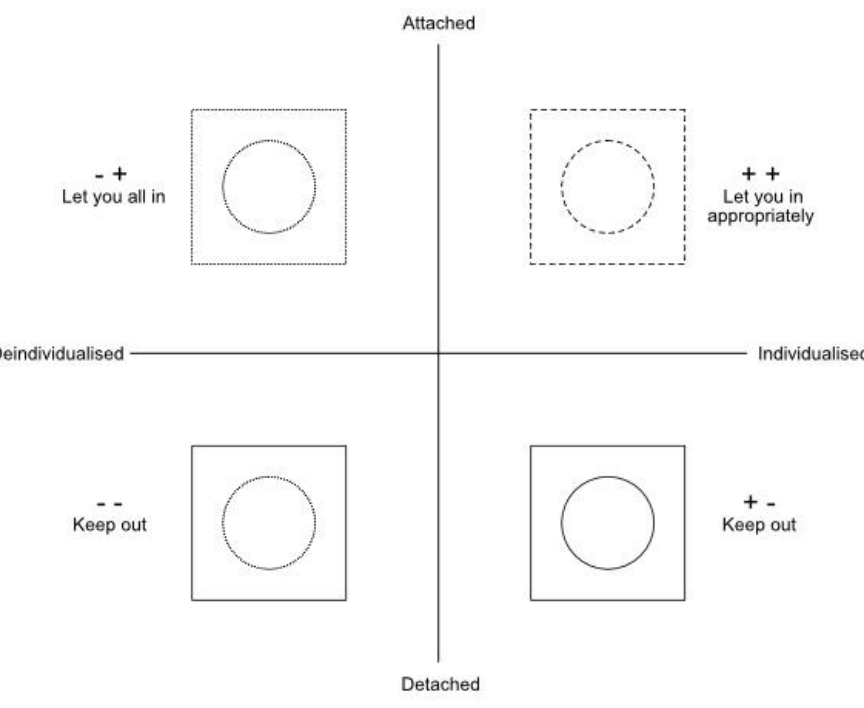
Figure 11: Interpersonal distancing patterns (amended from Kaplan, 1988, p.223)